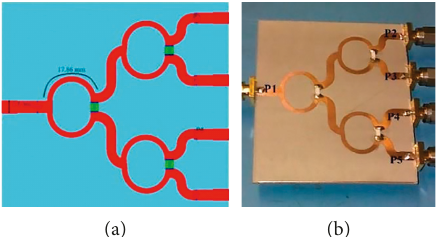
Figure 9: (a) The design of a 4:1 Wilkinson divider and (b) the fabrication of the 4:1 Wilkinson divider